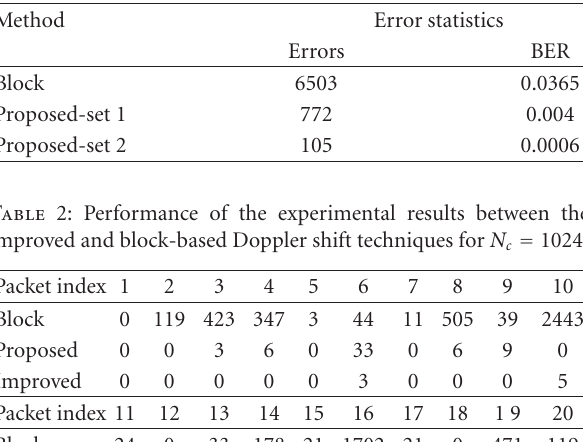
Figure 7: Sample of normalized channel impulse responses for 1000 m channel range. Table 1: Average BER comparison of the experimental results at di ff erent settings of weighting coe ffi cients between the proposed and block-based Doppler shift techniques for N c = 1024.